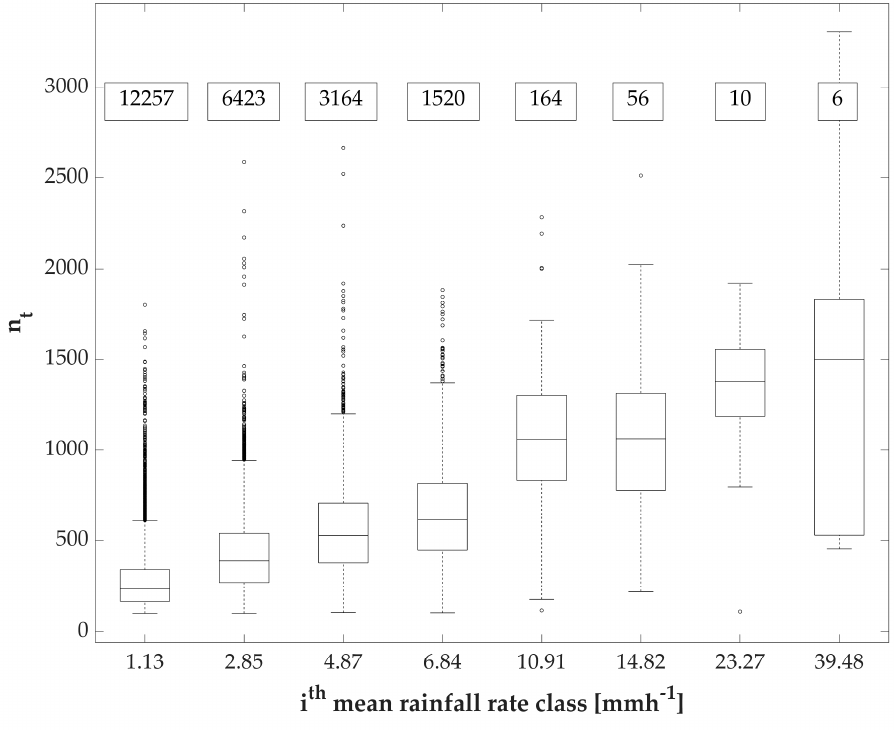
Figure 9. Number of total drops falling per each 1 min drop spectrum vs. average intensity class. In correspondence with each rainfall rate class, at the top of the panel inside the boxes, the number of 1